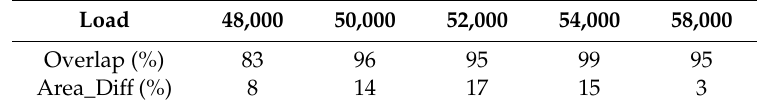
Table 6. Comparison of the predicted crack shape from ARIMA model against ground truth.